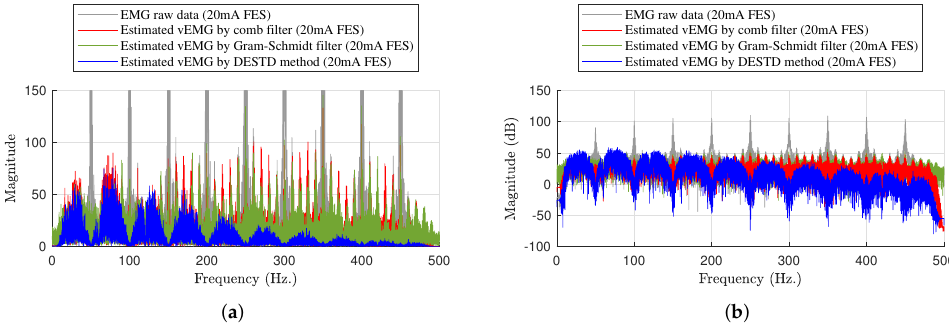
Figure 9. Frequency analysis example for experimental results at maximum stimulation intensity of 20mA: ( a ) Comparison of experimental results and ( b ) the result in dB